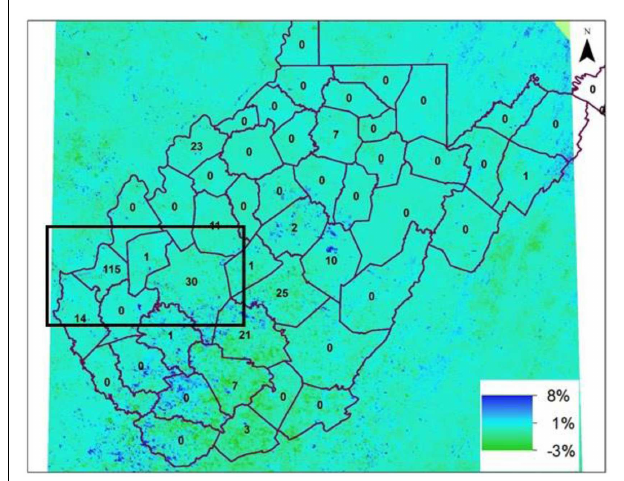
FIGURE 3 | Percentage change in LST in July 2012 with respect to July 2011 .The inset numbers on map are the percent difference inWNV positive mosquitoes during 2012 in counties ofWestVirginia compared to 2011. (Black box in the figure – 38.6825°N to 37.8788°N; 82.5844°W to 81.0955°; and include Cabell and Kanawha counties ofWestVirginia).